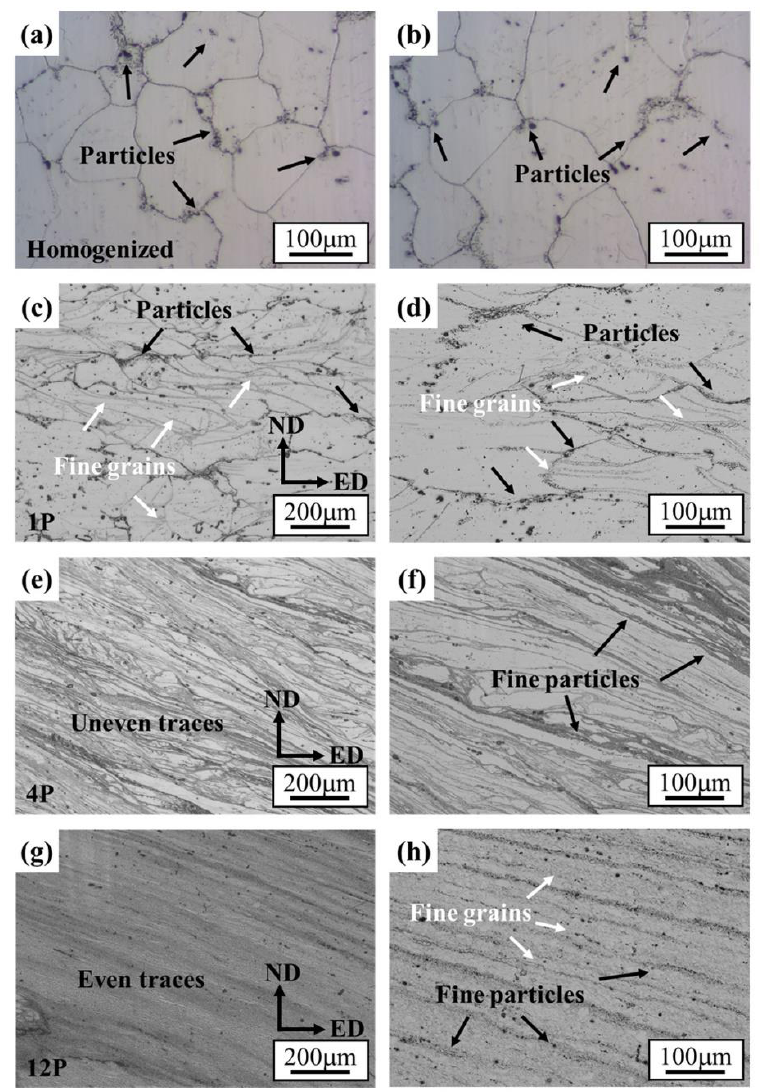
Figure 2. Optical micrographs of showing the microstructure evolution of ( a , b ) homogenized, ( c , d ) 1P, ( e , f ) 4P and ( g , h ) 12P samples.